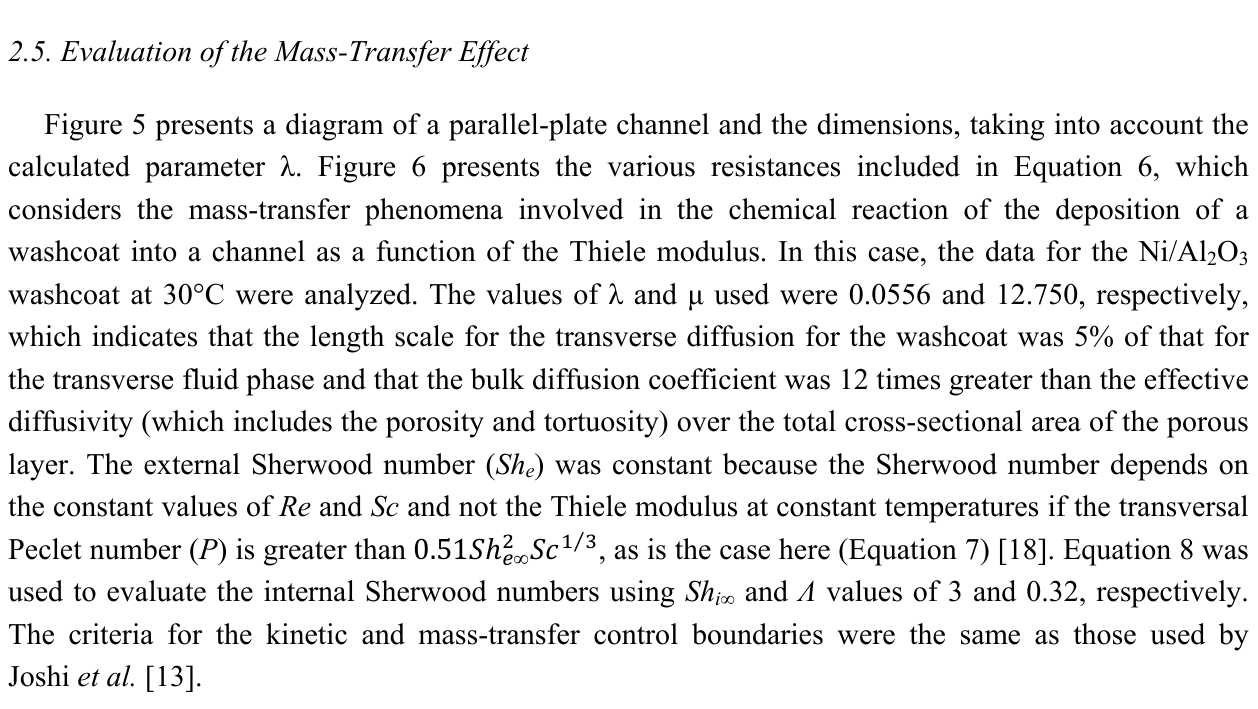
Figure 5. Dimensions of a channel of parallel-plate reactor with a washcoat applied to calculate the λ parameter. (cid:1844)